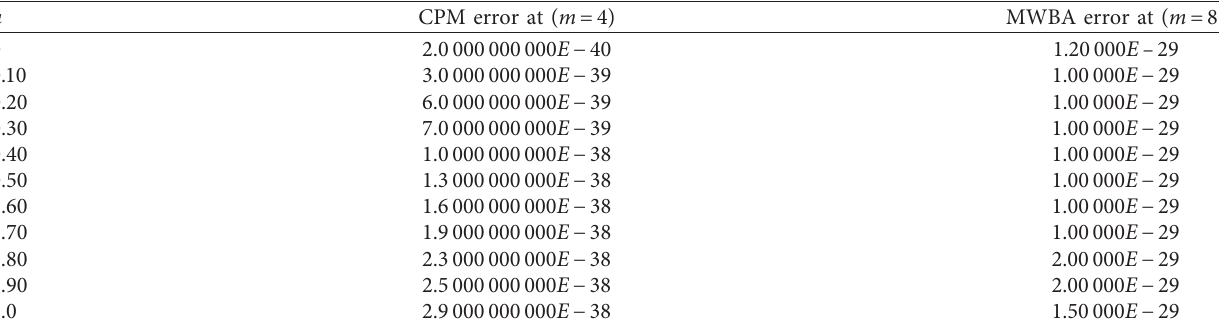
Table 8: Absolute error (A.E) comparison of CPM and other different methods for problem